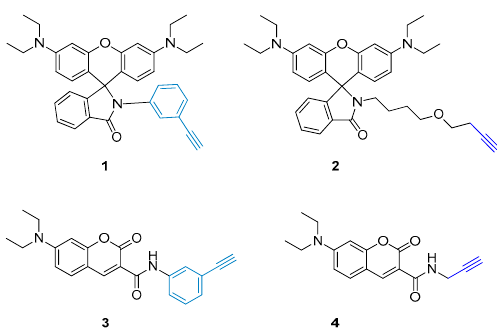
Figure 1. The chemical structures of four fluorescent probes used in this study. 1 and 2 are rhodamine B-based fluorescent probes. 1 contains a terminal aliphatic alkynyl group, and 2 has a terminal aryl alkynyl group. 3 and 4 are coumarin-based fluorescent probes. 3 contains a terminal aliphatic alkynyl group, and 4 has a terminal aryl alkynyl group.